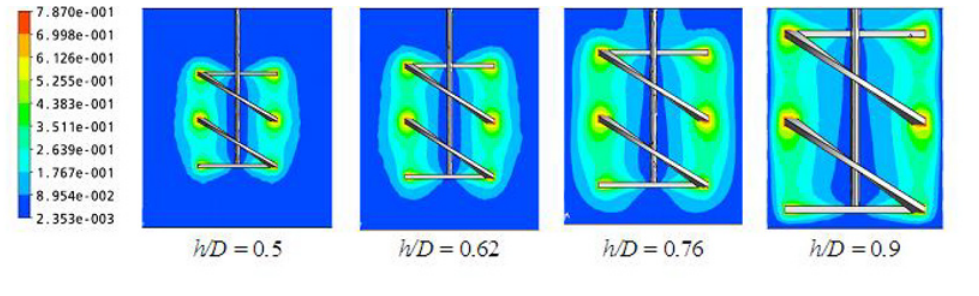
Figure 15. Flow fields for double helical ribbon impeller, at n = 0.8, Re